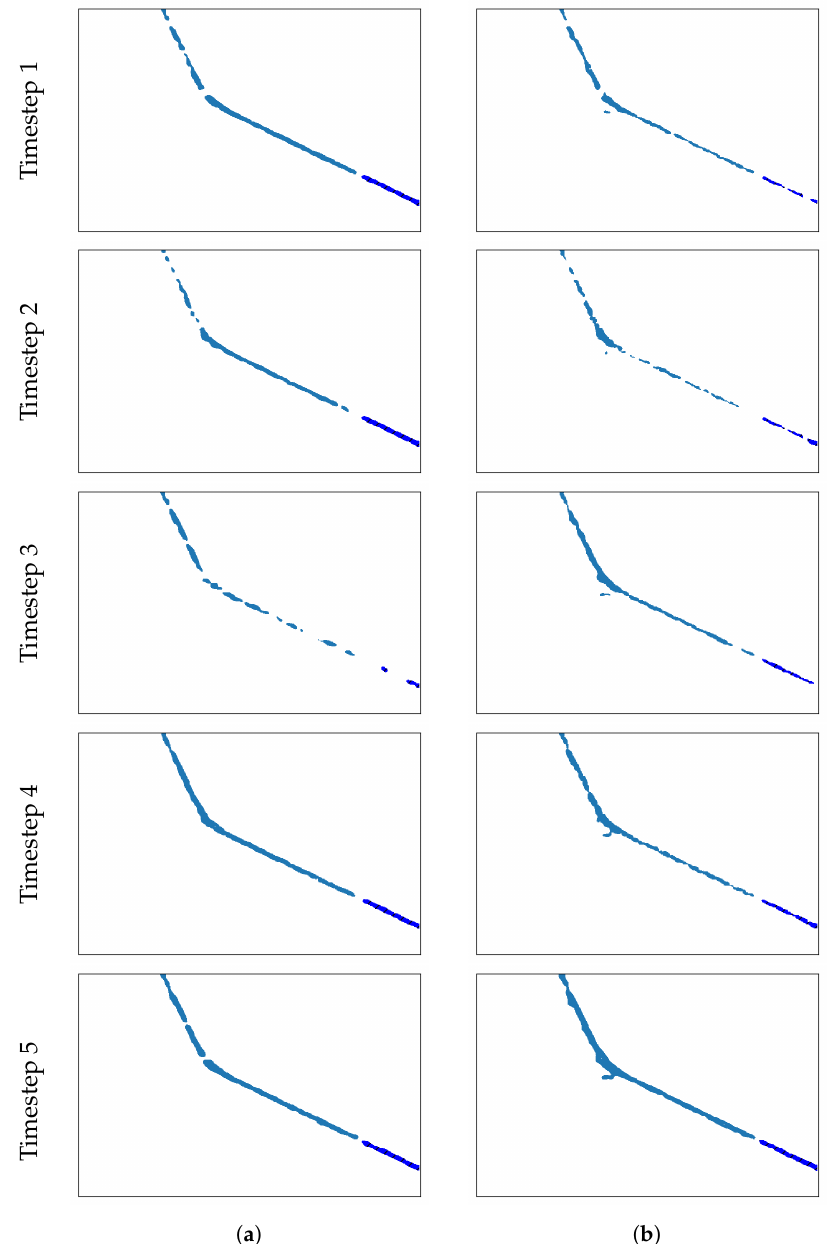
Figure 11. Active contour models (ACM) segmentation VV versus VH polarisation for ascending SITS in the static zone. ( a ) Ascending VV. ( b ) Ascending